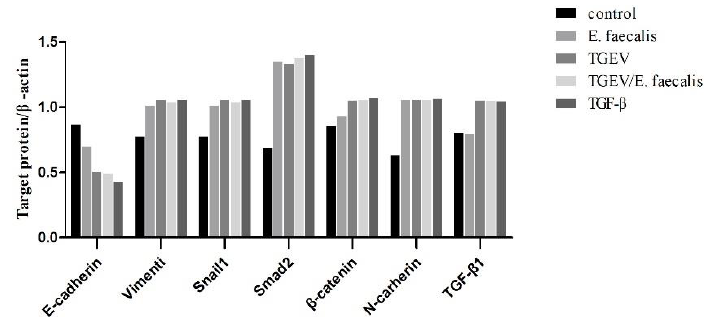
Figure A6. Gray analysis of western blot in Figure A3.